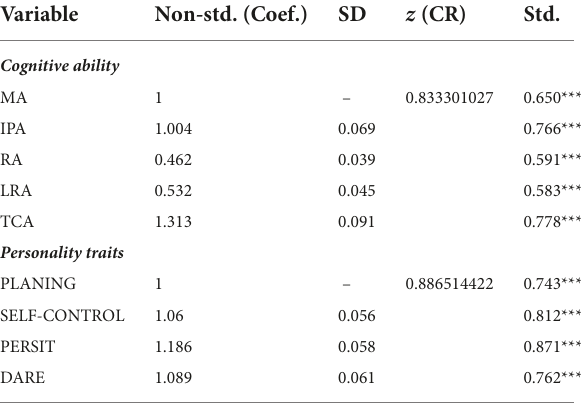
TABLE 3 Factor loading coefficient